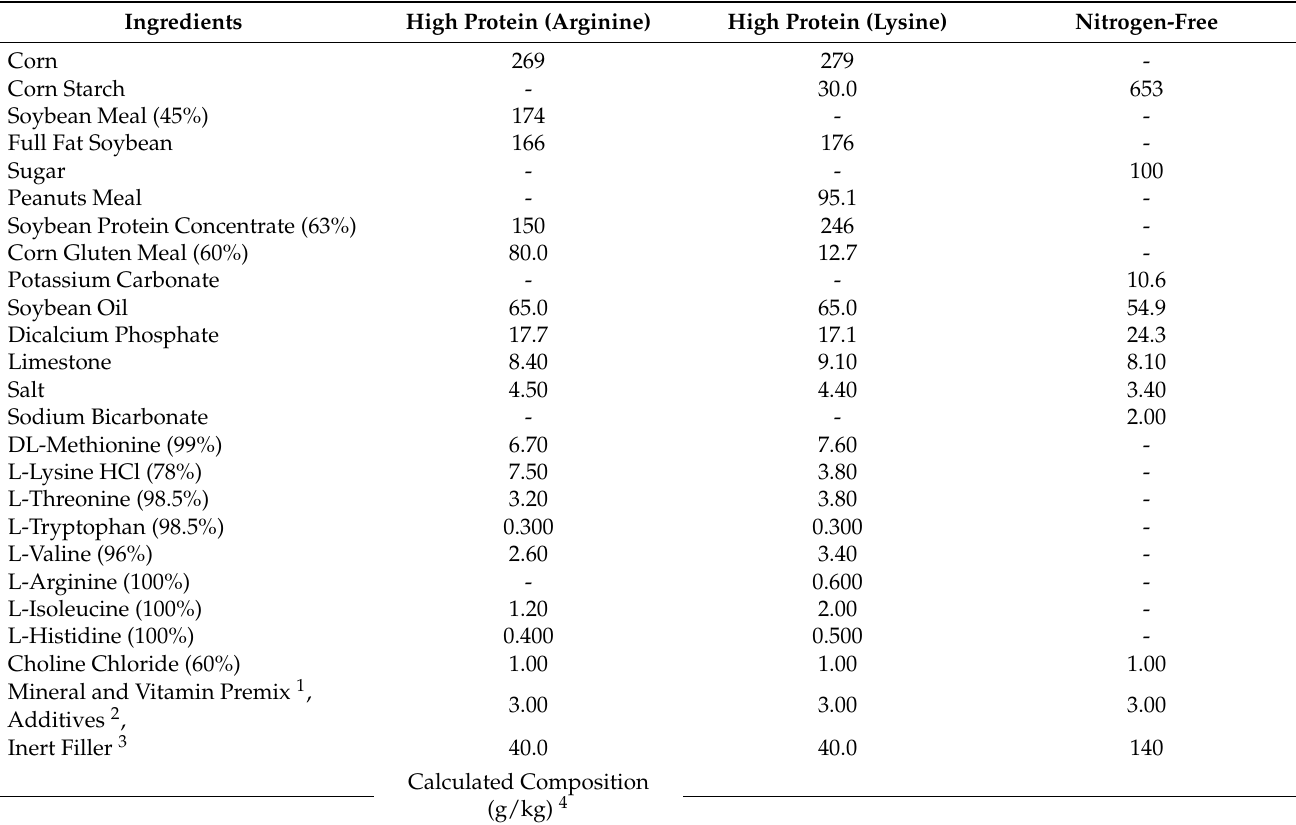
Table 1. Ingredients (g/kg) of the high-protein and nitrogen-free diets used on a dilution series to produce treatment feeds with crescent levels of lysine and arginine for broiler